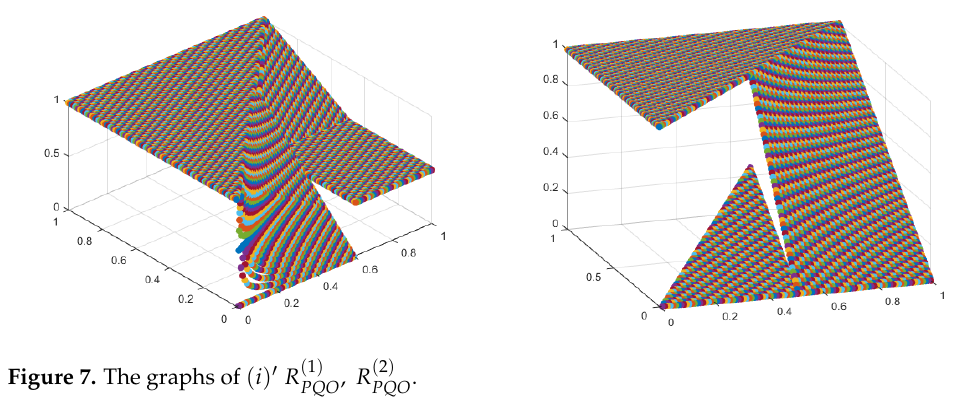
Figure 7. The graphs of ( i ) (cid:48) R